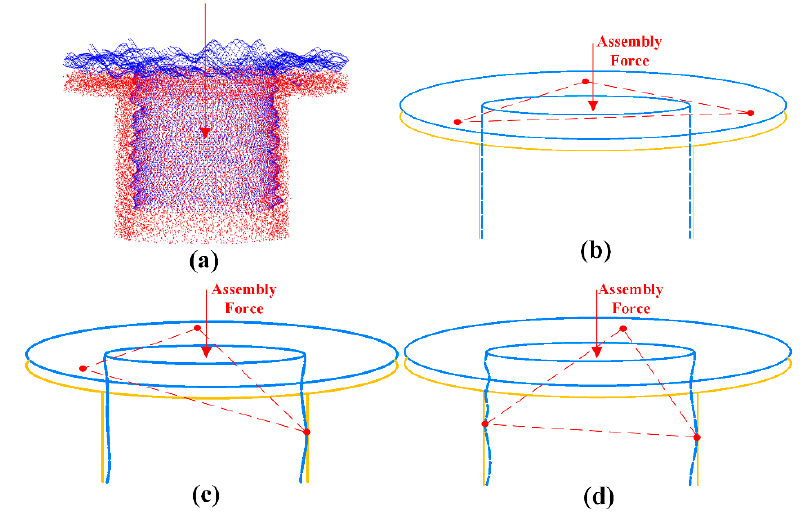
Figure 7. Numerical experiments ( a ) and three basic patterns of contact point positions ( b – d ).